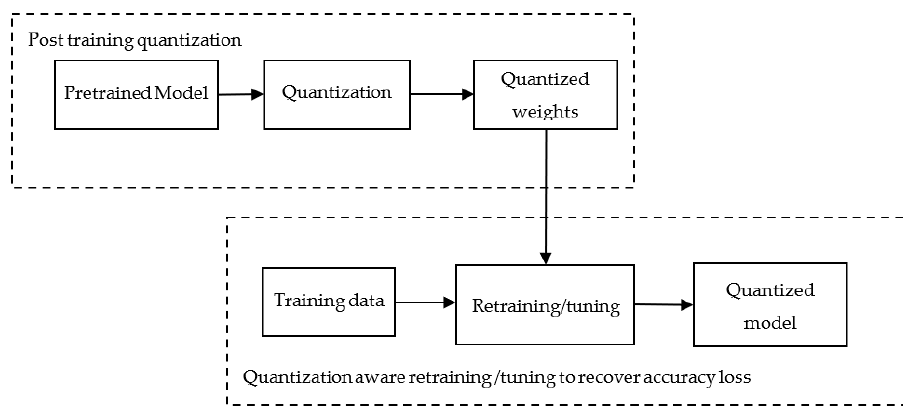
Figure 13. Post - training quantization and quantization-aware retraining.